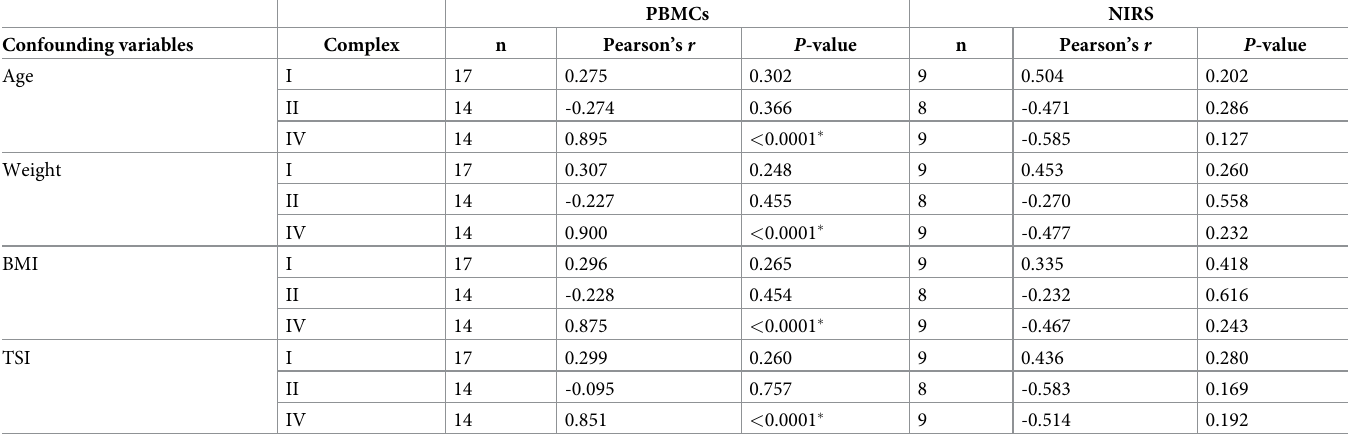
Table 3. Partial correlations between permeabilized muscle fiber and monocyte or NIRS bioenergetics after independently controlling for age, weight, BMI, or